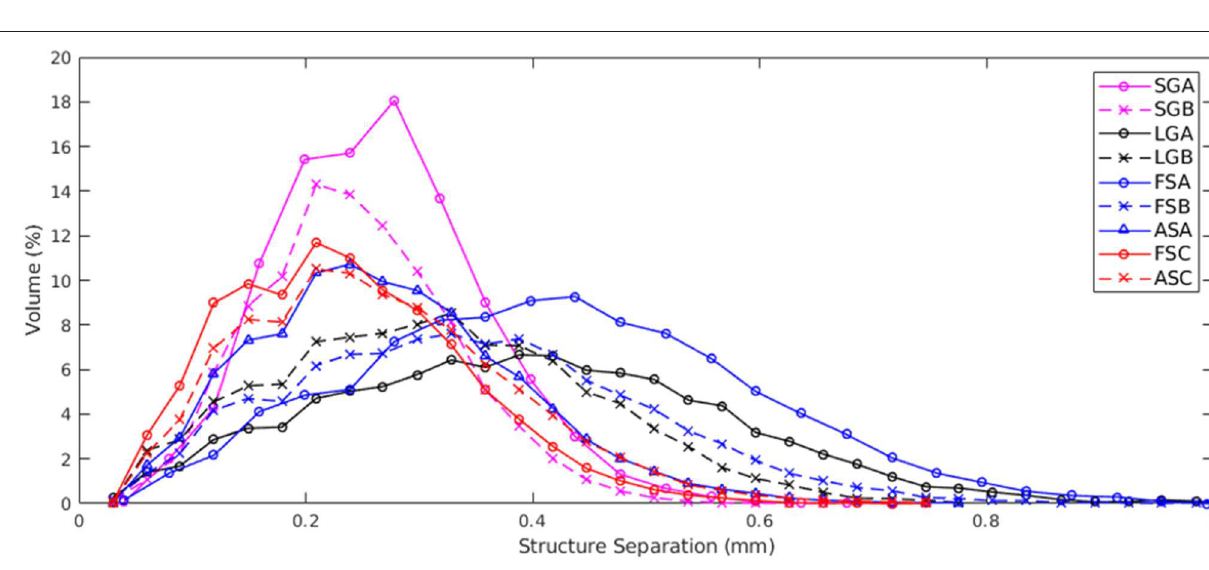
that there appears to be distinct classes separating the snow types again, but they are different from the structure